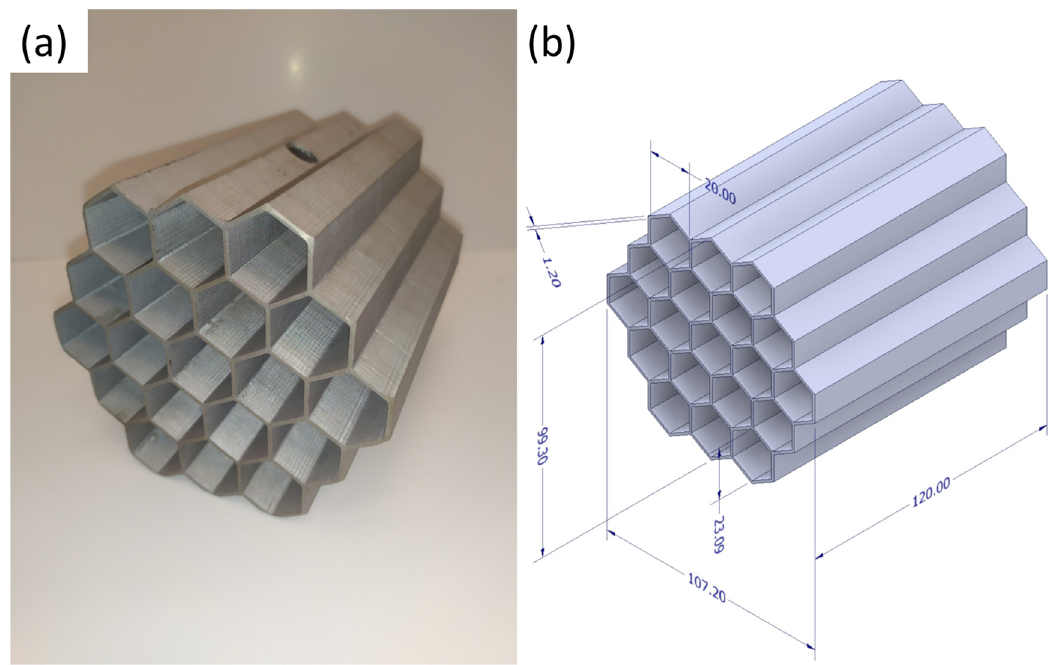
Figure 4. The honeycomb structure: ( a ) cast element made of EN AC 44200 Al-Si alloy; ( b ) dimensions of 1.2 mm wall-thick structure (in experiment and simulation).